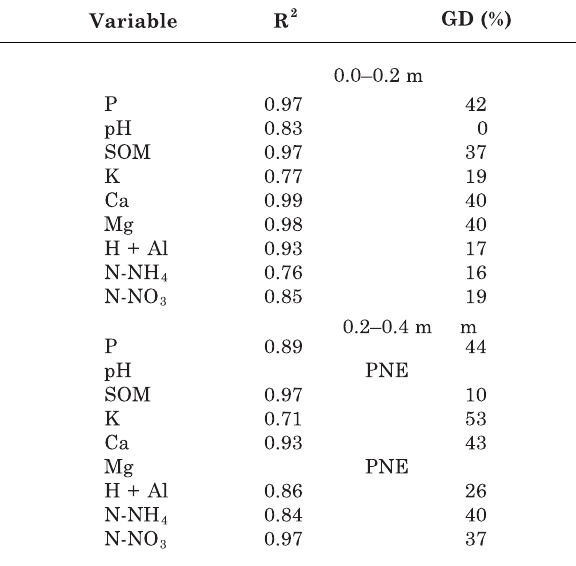
R 2 : adjusted determination coefficient of the model; GD: degree of spatial dependence; PNE: pure nugget effect; SOM: organic